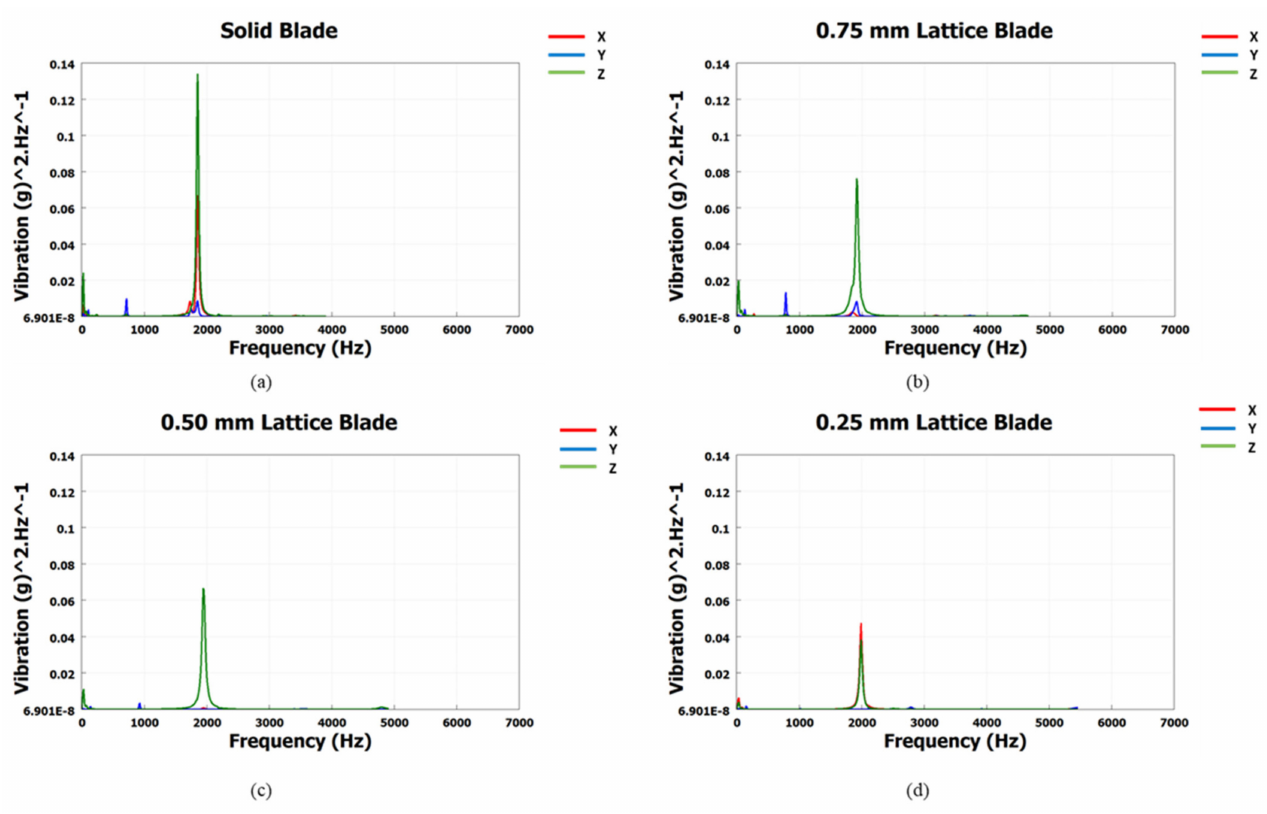
Figure 14. Response PSD results of turbine blades: ( a ) the solid blade; ( b ) the 0.75 mm lattice blade; ( c ) the 0.50 mm lattice blade; ( d ) the 0.25 mm lattice